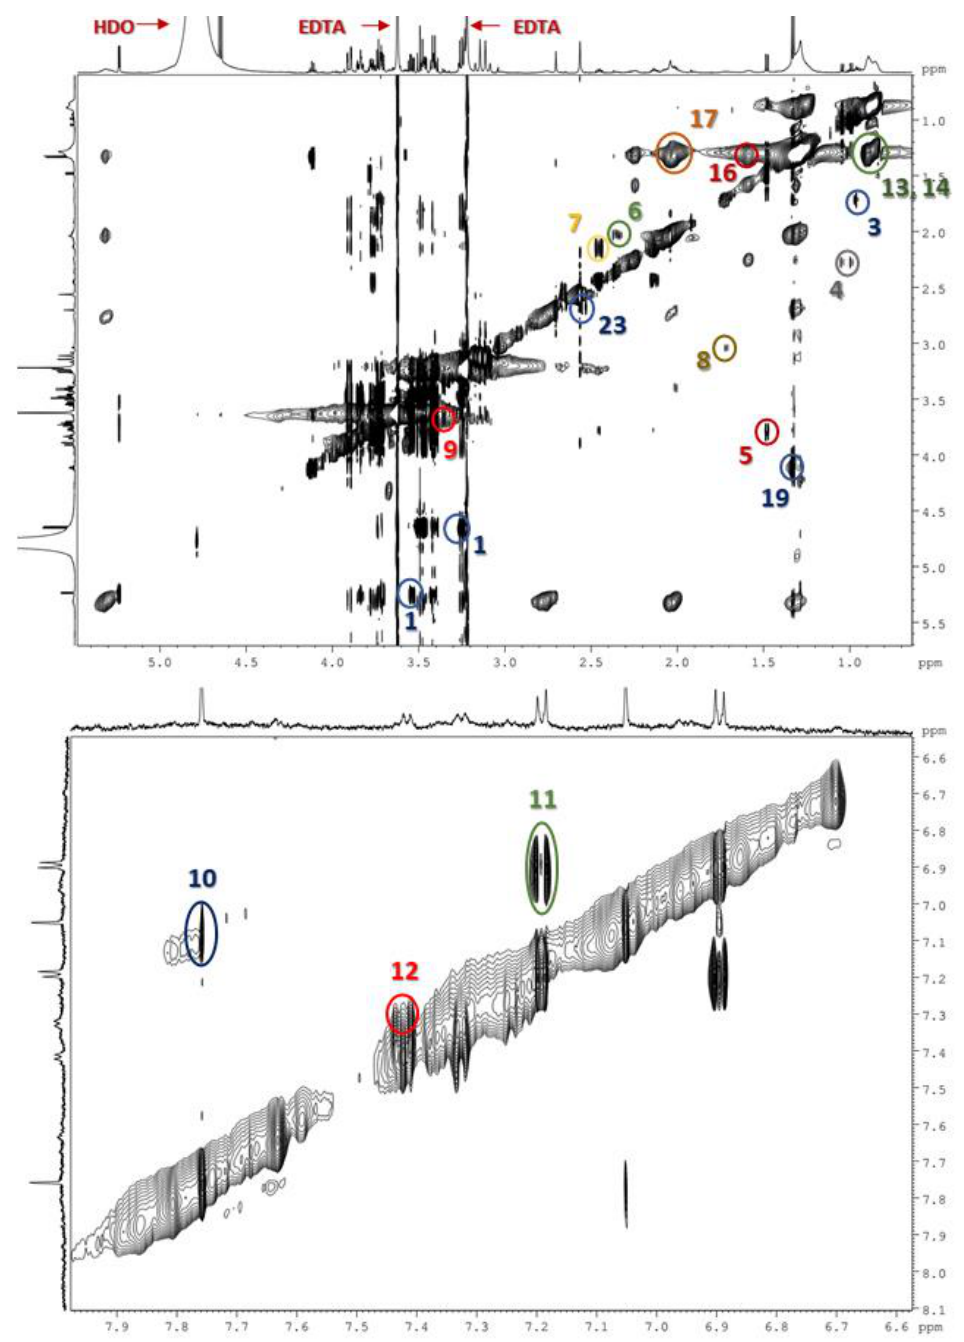
Figure A1. 2D TOCSY 1 H- 1 H NMR obtained for one plasma sample. Spectral region 0.50 to 5.50 ppm is shown on the upper panel, and the region from 6.6 to 7.9 ppm is given on the bottom panel. The following metabolites were identified: 1. Glucose; 3. Leucine; 4. Valine; 5. Alanine; 6. Glutamate; 7. Glutamine; 8. Arginine; 9. Proline; 10. Histidine; 11. Tyrosine; 12. Phenylalanine; 13. LDL: Low-Density Lipoproteins; 14, VLDL: Very Low-Density Lipoproteins; 16. Fatty-Acid Chain; 17. Unsaturated lipids and N -acetyl-glycoproteins; 20. Lactate; 23. Citrate. (Numbers refer to ones shown in Table A1).